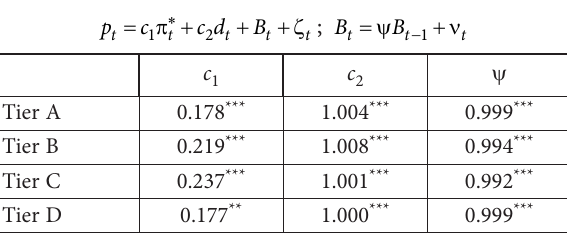
Panel B: The Johansen cointegration test